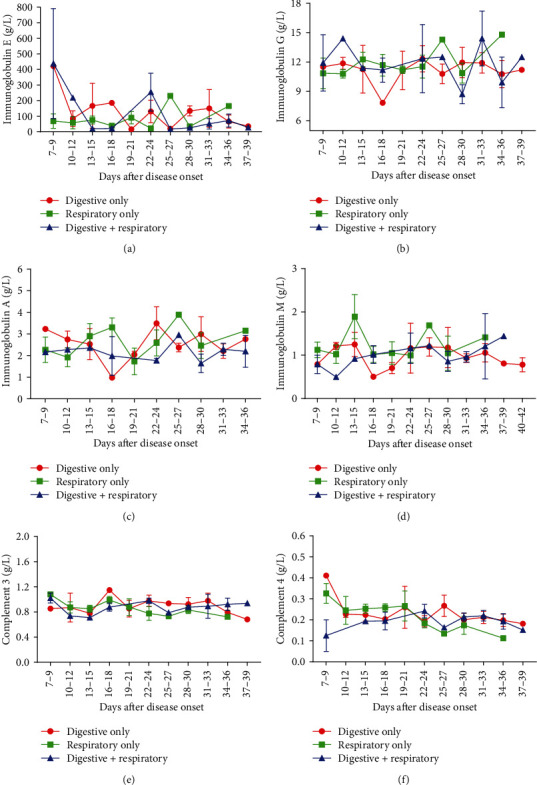
Dynamic profile of immunoglobulin and complement levels in COVID-19 patients with different symptoms. Timeline charts illustrate the levels of IgE (a), IgG (b), IgA (c), IgM (d), C3 (e), and C4 (f). Error bars, mean ± SEM; ∗∗P < 0.01, Digestive Only vs. Respiratory Only. ##P < 0.01, ###P < 0.001.